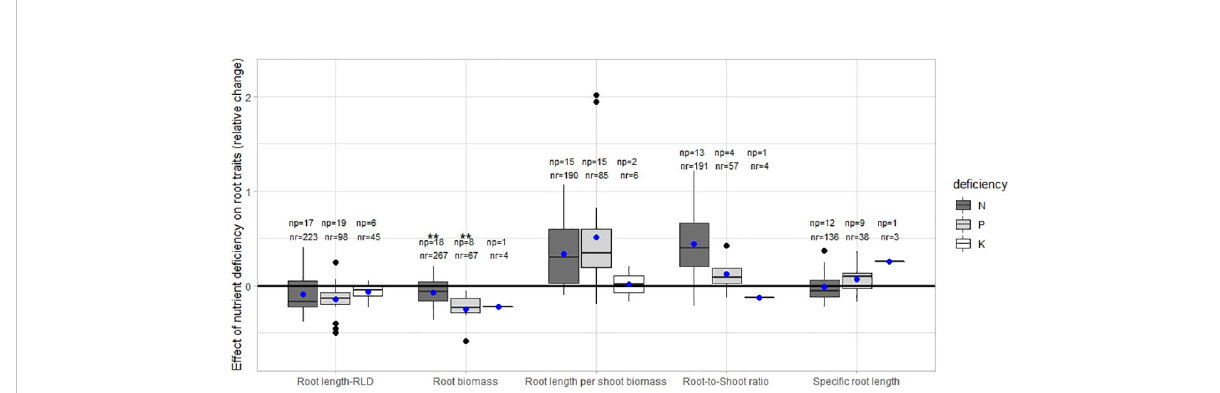
FIGURE 1 The relative change of the root traits under de fi ciency [(X0-X1)/X1] where X0 is the value in the treatment without any addition of the nutrient and X1 is the value of the treatment with the nutrient application. np stands for the number of publications/studies considered in the calculation, and nr for the total number of observations within these publications. The line within the boxes refers to the median. ** stands for signi fi cant differences at a 0.95 con fi dence level. Blue dots represent the